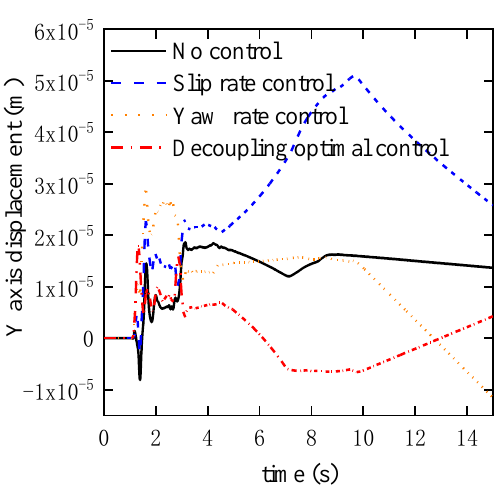
Figure 11. Displacement in the Y -axis direction.